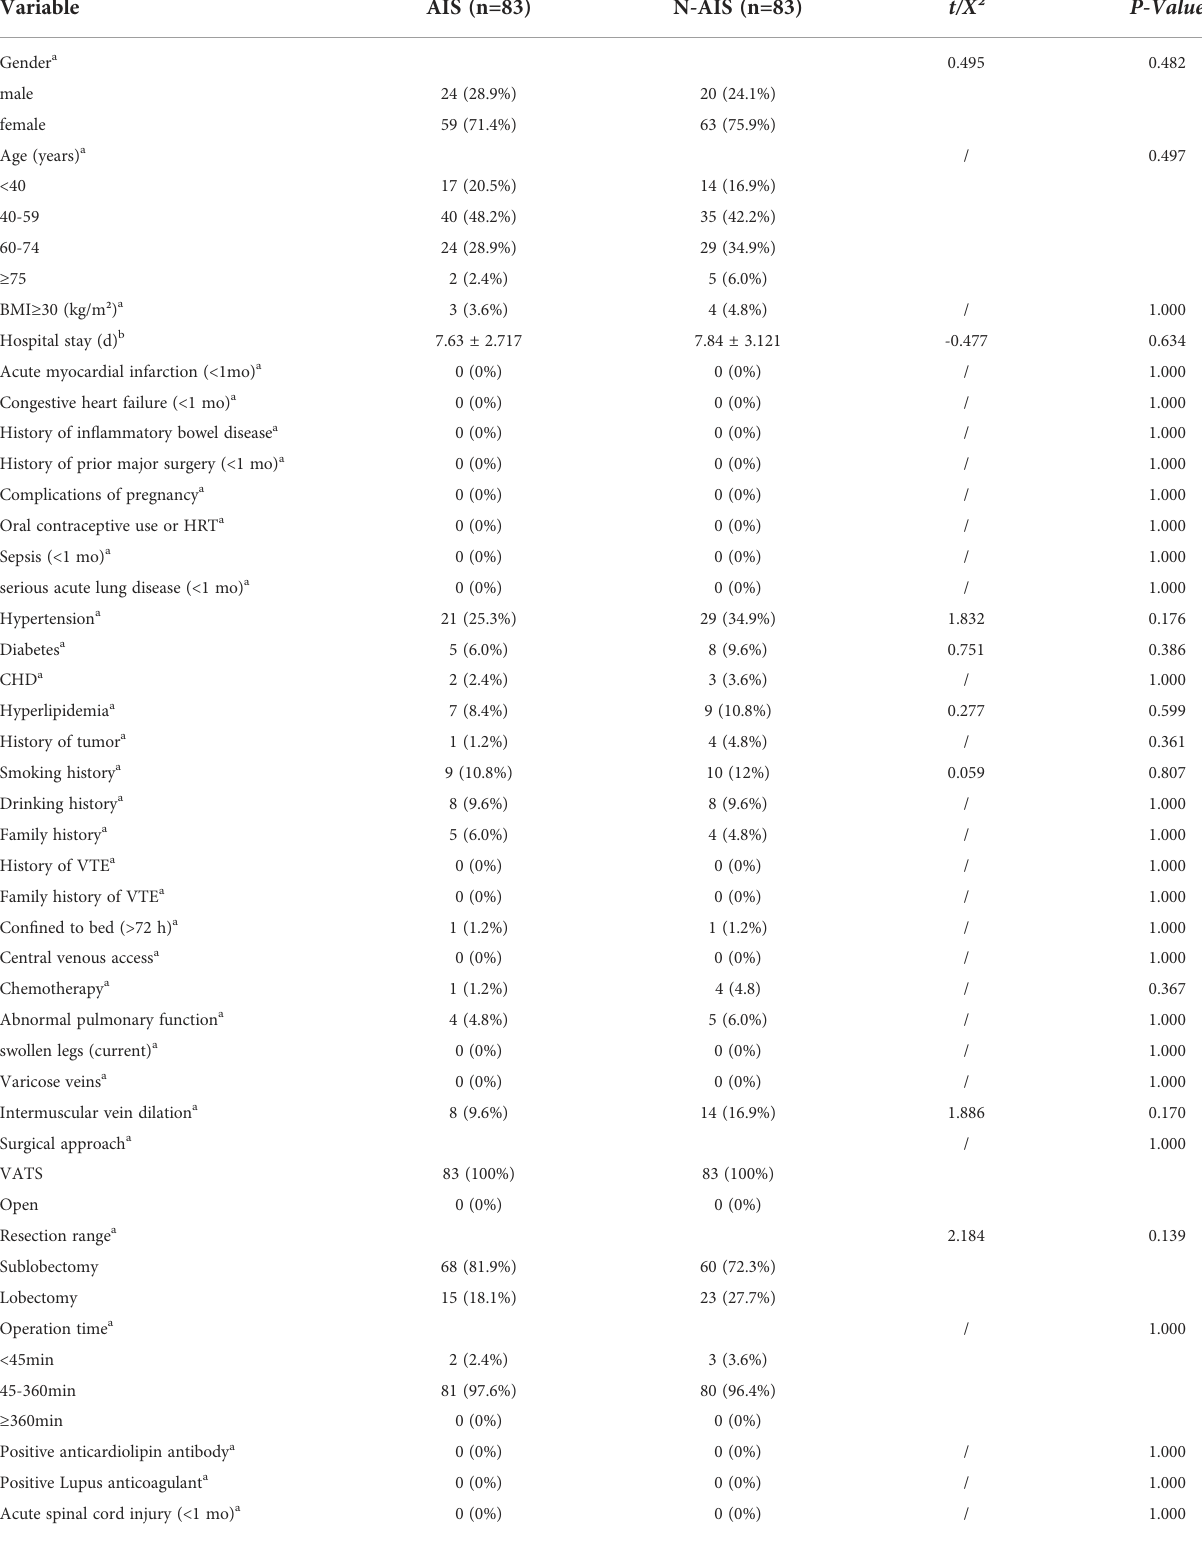
TABLE 3 Comparison of baseline data between AIS group and AD group after